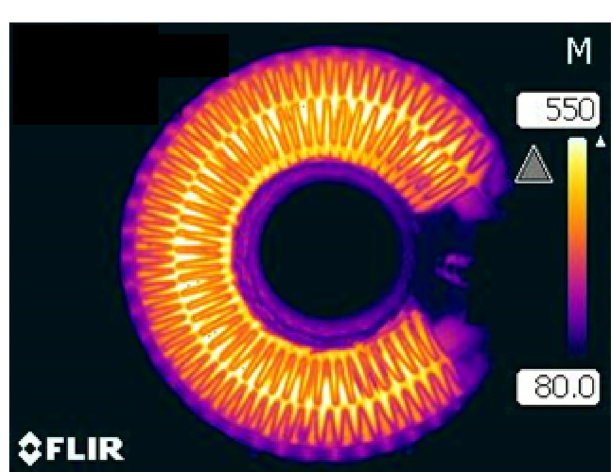
Figure 2. Thermal image of an electrically heated filter cartridge, high temperature of 550 °C.